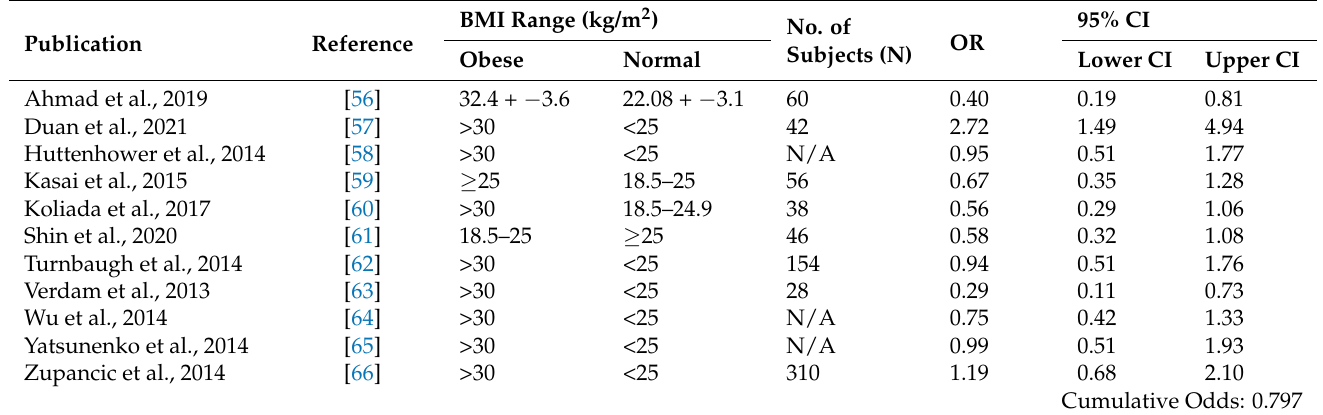
Table 2. Microbiota and obesity data from the considered studies.